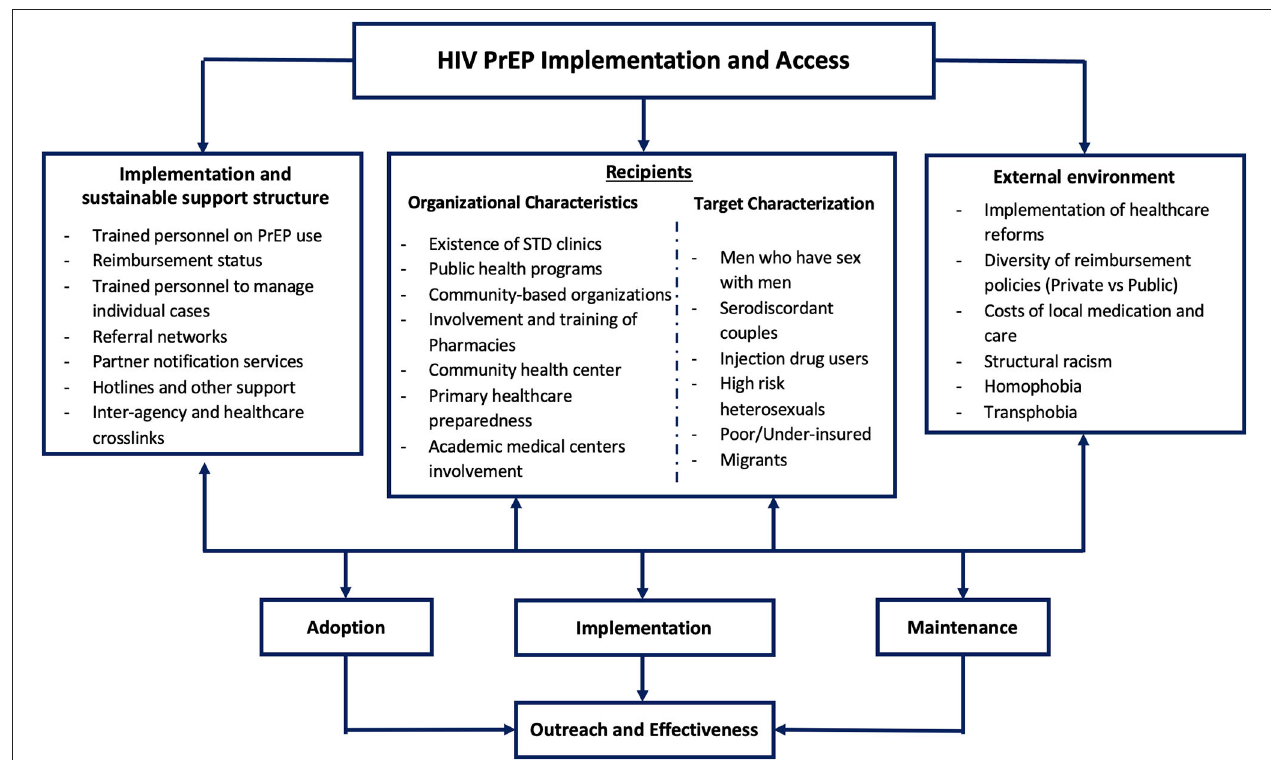
FIGURE 4 | Factors involved in PrEP implementation and access as originally proposed by Mayer et al. (44), with